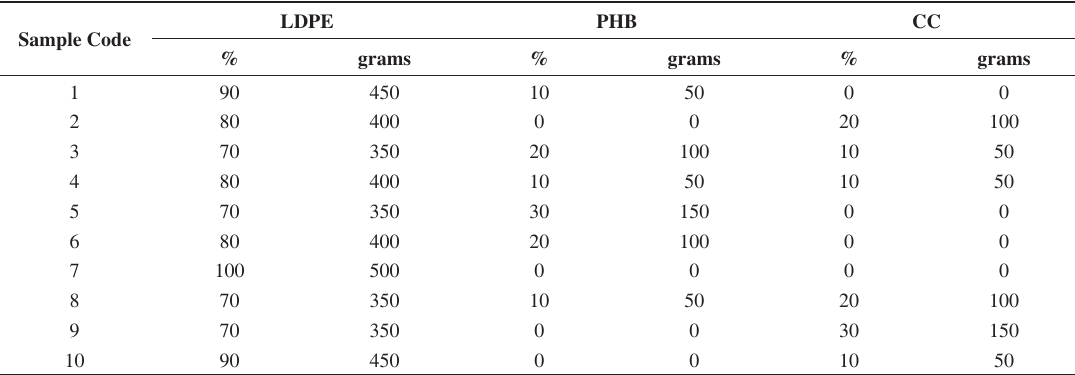
Table 2. Composition of LDPE/PHB/CC